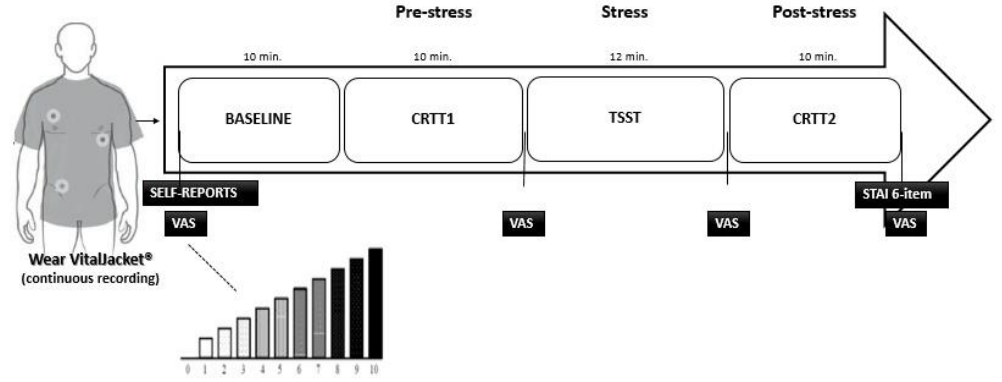
Figure 2. Diagram of the protocol. VAS—Visual Analogue Scales. CRTT—Choice Reaction Time Task. TSST—Trier Social Stress Test. Self-reports—include demographic, medical survey and State-Trait Anxiety Inventory (STAI) six-item.